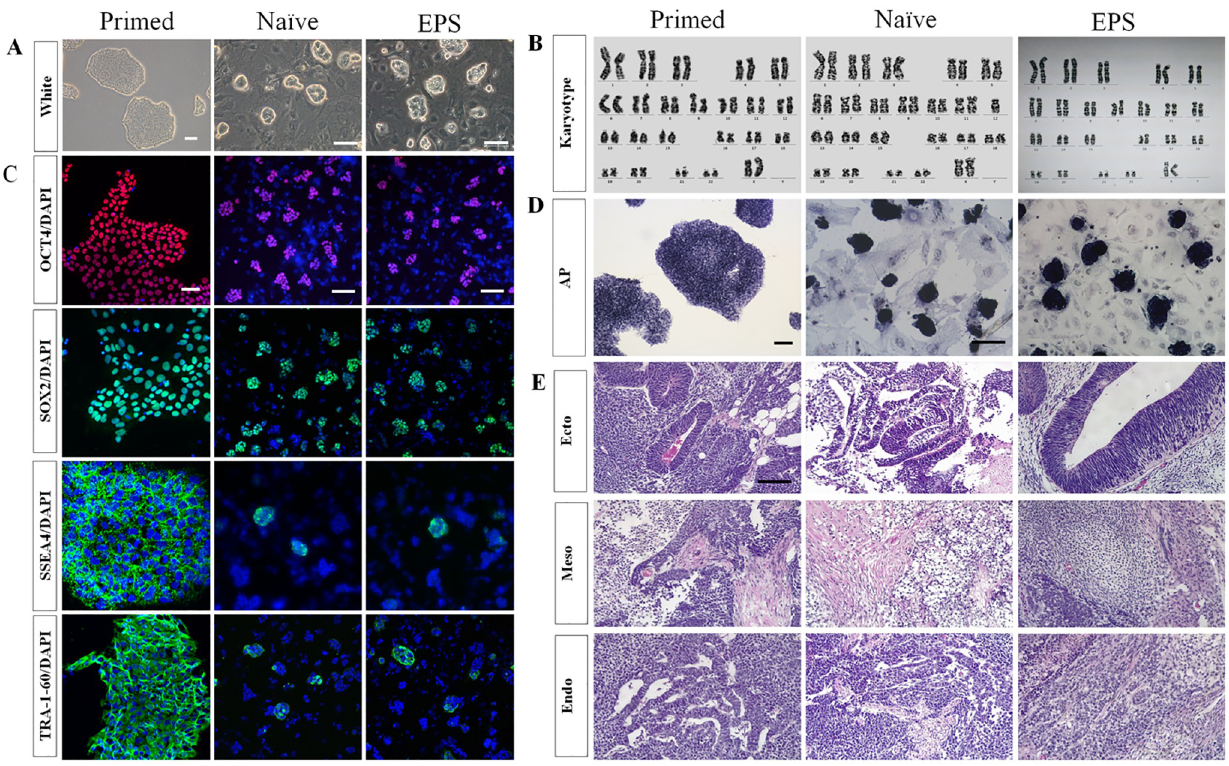
Fig 1. Conversion of primed hPSCs in different culture conditions. (A) Morphological analysis of hPSCs cultured in RSeT and N2B27-LCDM media and their transition from primed pluripotency-specific flat morphology towards dome-shaped undifferentiated naive colonies; (B) Chromosome analysis by colchicine shows normal karyotype of all cell lines; (C) Immunostaining for OCT4, SOX2, SSEA4 and TRA-1-60 is shown counterstained with DAPI; (D) Positive staining for alkaline phosphatase (AP); (E) Teratomas formation analysis revealed that the teratomas tissues were composed of the three germ layers; scale bar = 100 μ